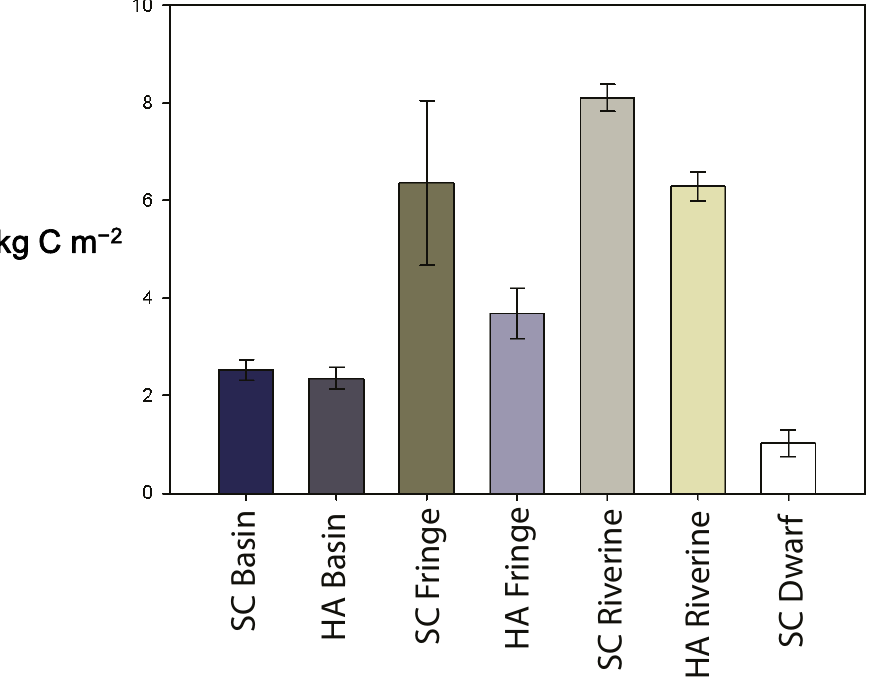
Figure 4. Soil carbon pools (mean ˘ standard error) of different mangrove landscapes for hydrologically disturbed Hamilton Avenue Creek (HA) and reference Susan’s Creek (SC). Carbon pools have been calculated to a standard 20 cm